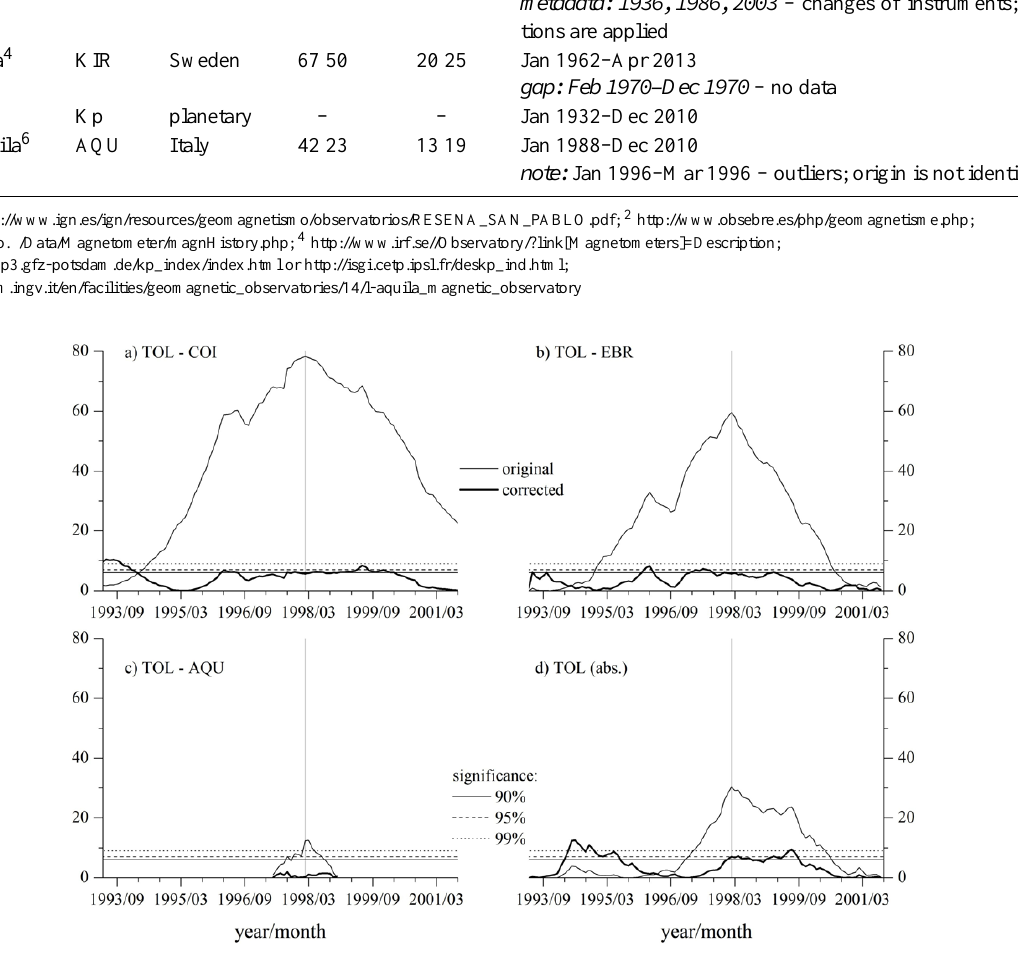
Fig. 2. Homogeneity test statistics for TOL Ki in relative (compared to Ki from COI (a) , EBR (b) , AQU (c) ) and in absolute (d) modes around the 1998 epoch. Thin lines – before correction; thick lines – after correction. Significance levels are marked by horizontal lines. Vertical grey line shows the break date for TOL